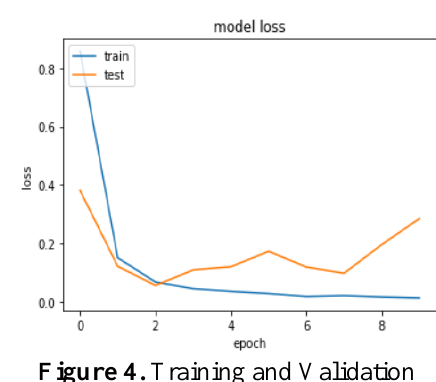
Figure 3. Training and